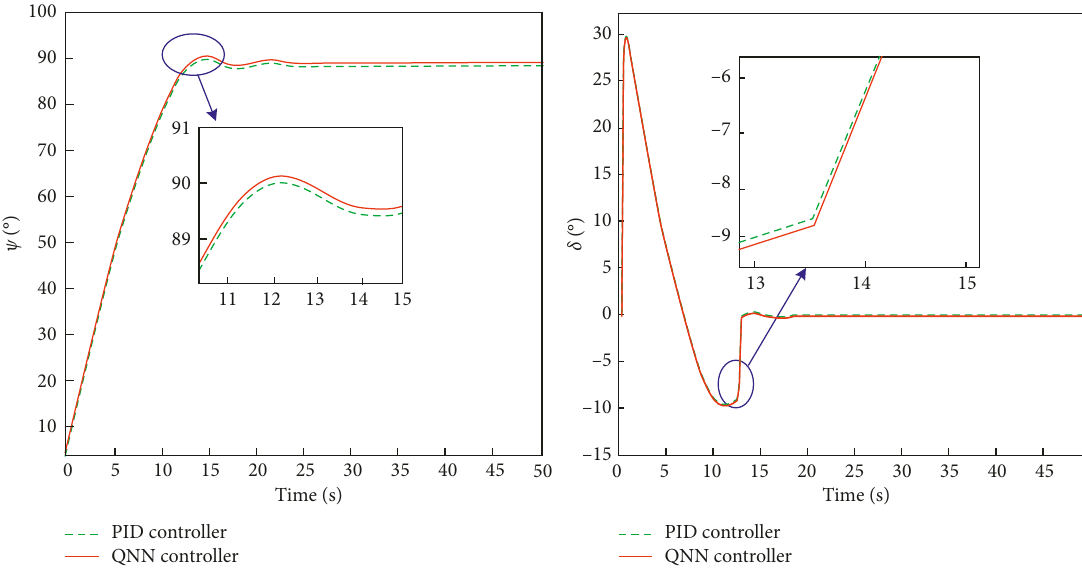
Figure 7: The course keeping simulation results for the PID and QNN steering controller.